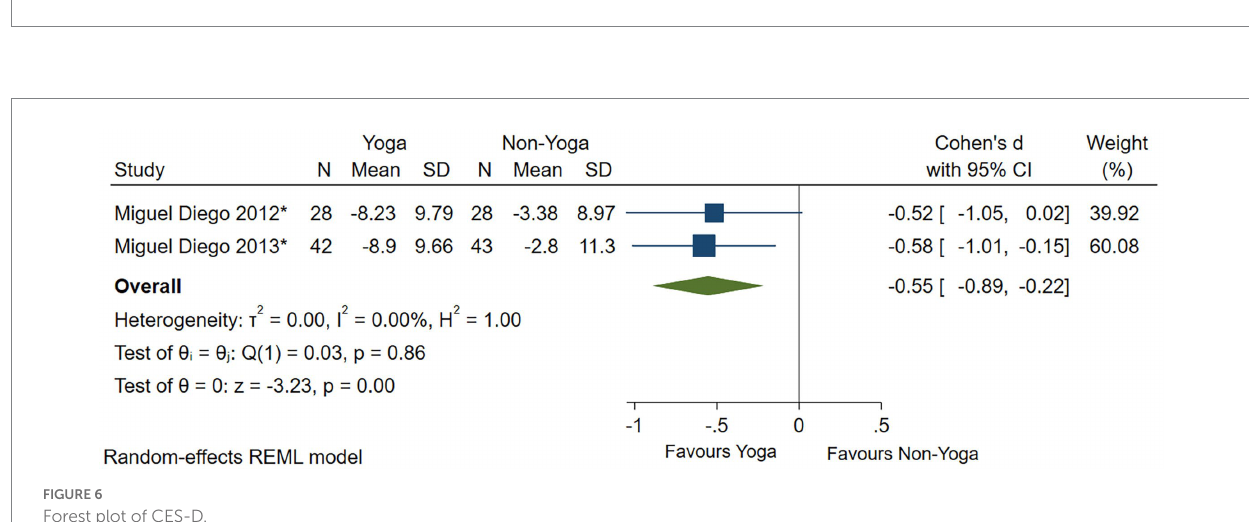
FIGURE 5 Forest plot of